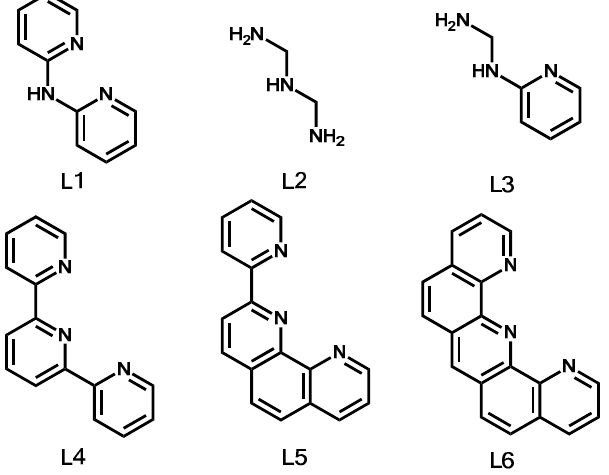
Figure 1. Structures of the six tridentate nitrogen ligands.